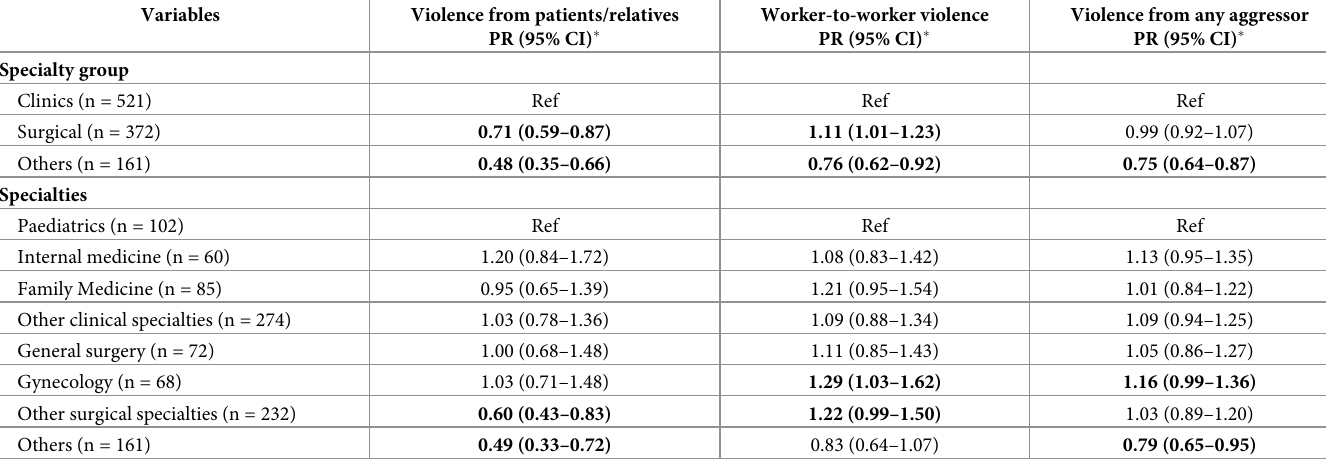
Table 4. Medical specialties associated with workplace violence according to type of aggressor (n = 1054).